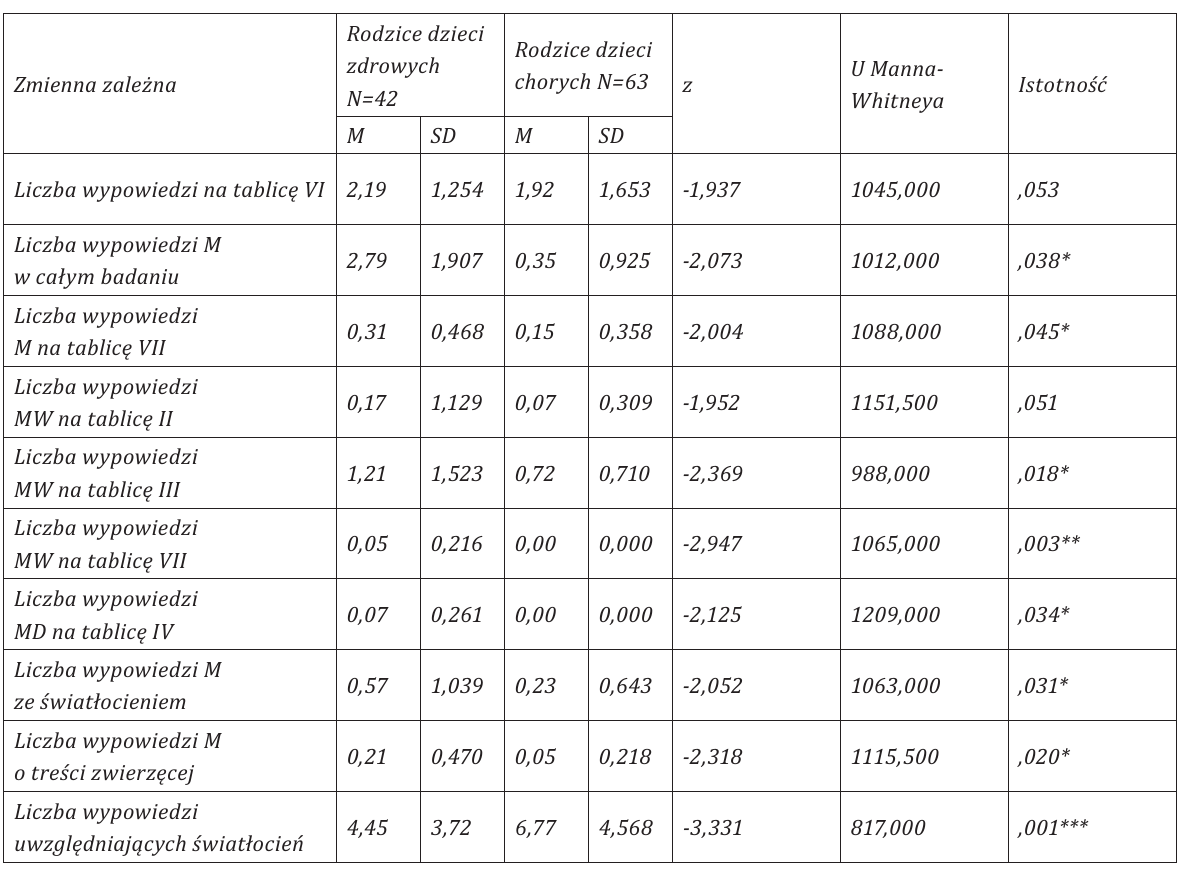
tablicy IV trudniej im było zobaczyć ruch ludzki w dużej, dobrze wydzielonej części. Rodzice ci rzadziej też łączyli ruch ludzki ze światłocieniem. A jednak, wypowiedzi uwzględniające światłocień pojawiające się w